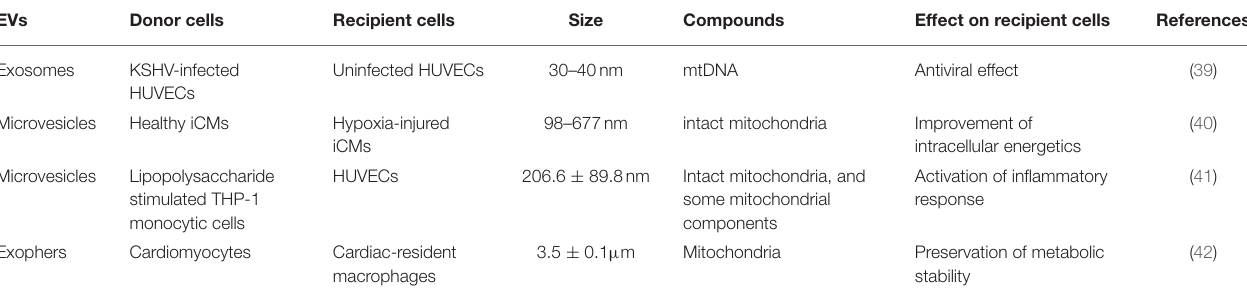
TABLE 2 | Characteristics of mitochondrial transfer-related EVs in cardiovascular system. EVs Donor cells Recipient cells Size